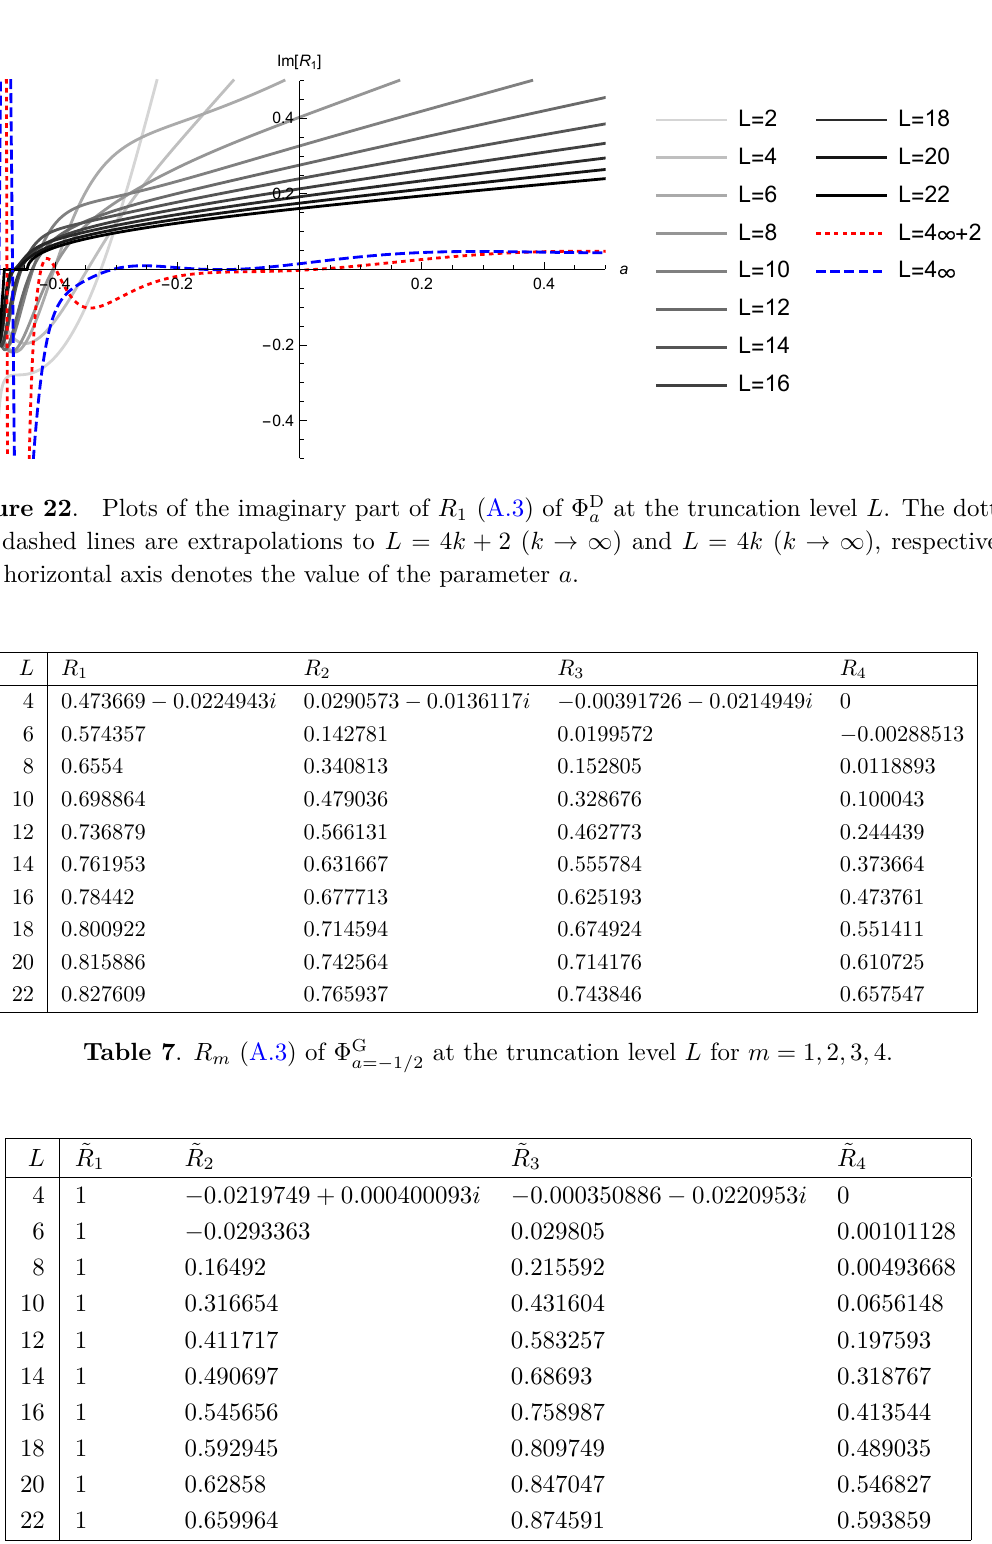
Table 8 . ˜ R m (A.4) of Φ G at the truncation level L for m = 1 , 2 , 3 , 4 a = − 1 / 2